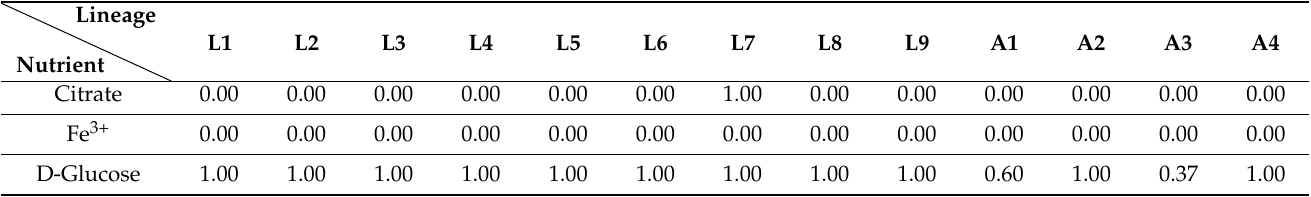
Table 1. Minimum growth requirements of lineage-specific models for sustaining the growth rate of the L7 model. The unit is mmol/(gDW ·